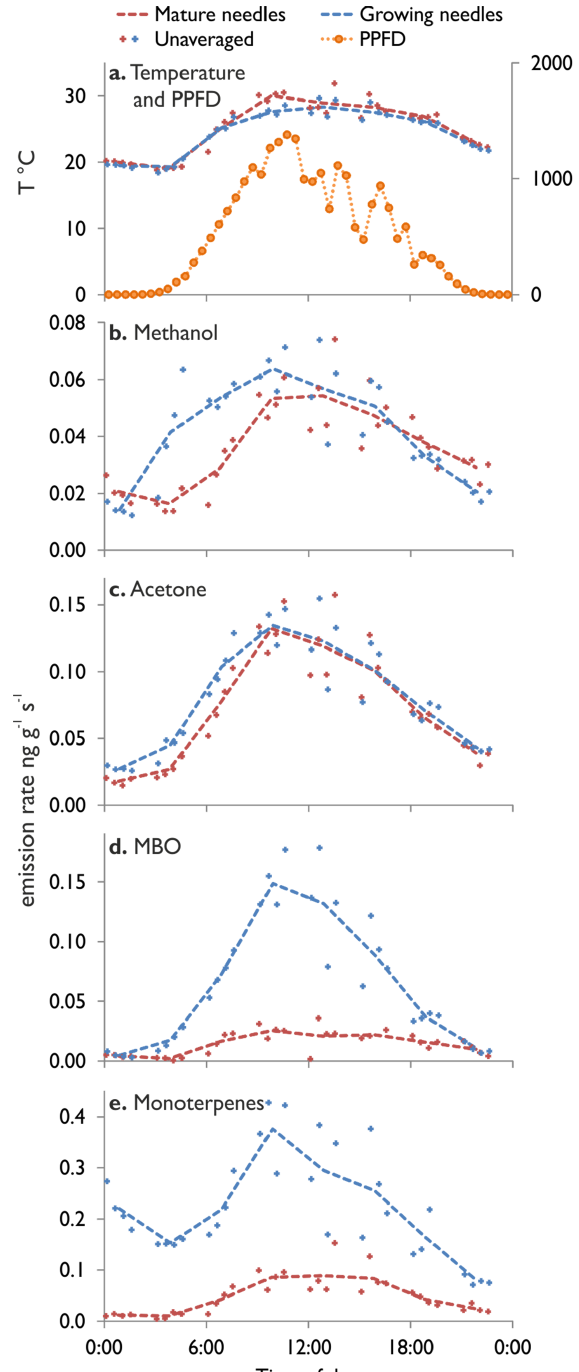
Fig. 5. The diurnal pattern in VOC emission rates from a mature and a developing Scots pine shoot on 8 July 2011. (a) Tempera- ture inside enclosure and photosynthetic photon flux density. (b–e) Emission rates of different compounds. Crosses represent individ- ual measurements, and dashed lines are 3-hour averages.